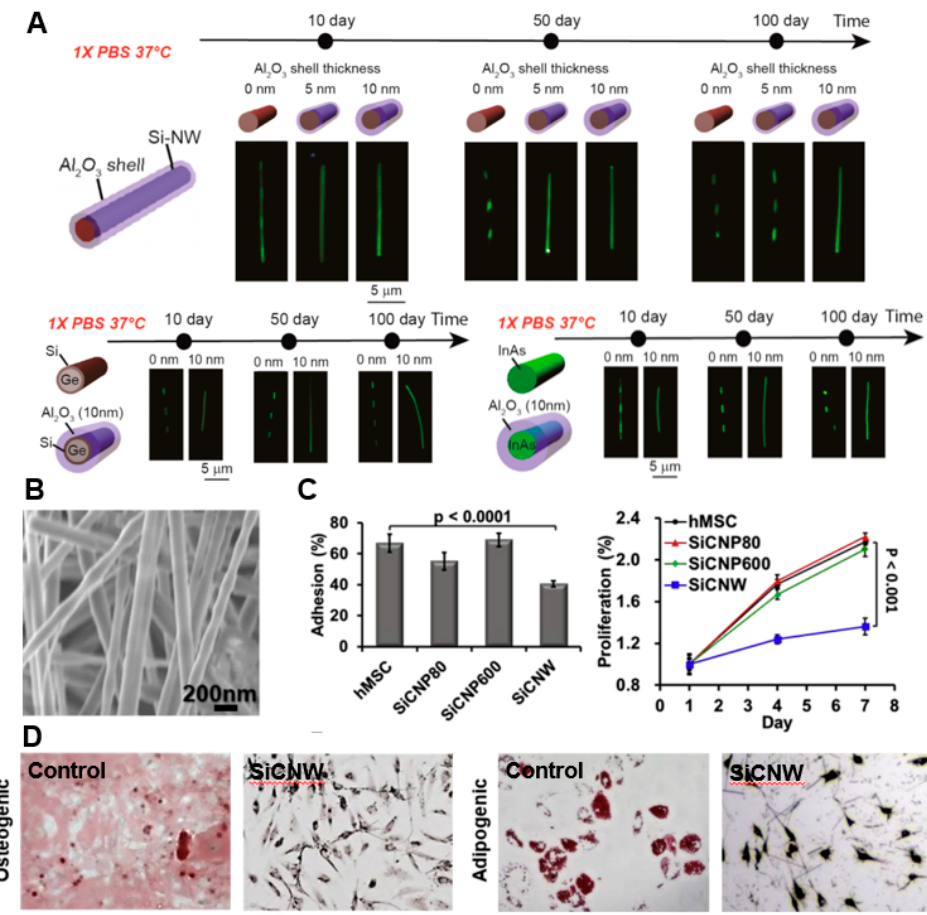
Figure 4. Design nanowires for in vivo sensing. ( A ) Improving long-term stability by Al 2 O 3 shell coating (adopted with permission from [89]). ( B – D ) Cytotoxic effects of SiC nanowires to cell behavior and differentiation (adopted with permission from [89]). (B) SEM pictures of SiC nanowires. (C)